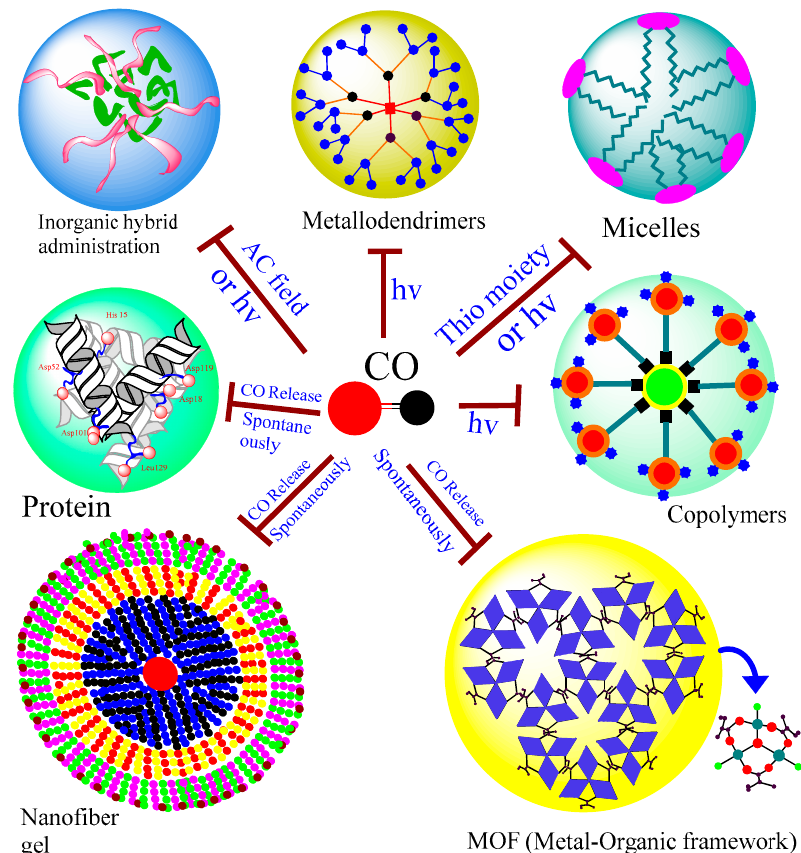
Figure 5. The CO-releasing administration with di ff erent conjugate and encapsulate strategies. Figure 5. The CO ‐ releasing administration with different conjugate and encapsulate strategies.